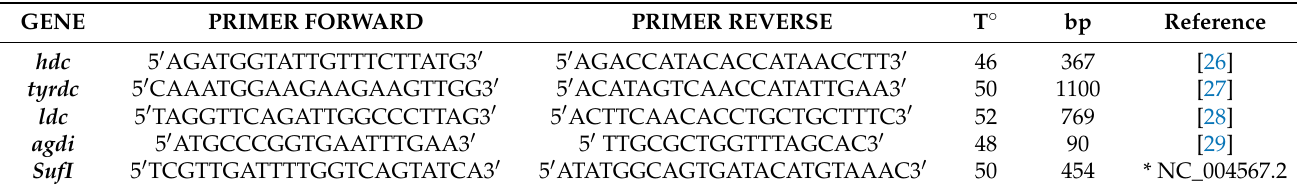
Table 1. Lists of primers to detect the genes involved in the formation and degradation of BAs. GENE PRIMER